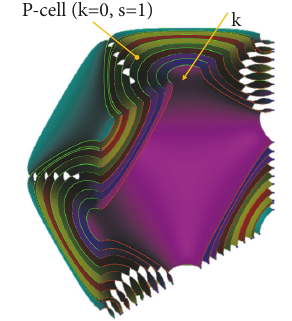
Figure 3: Several P-cells (s = 1 ) obtained varying the k